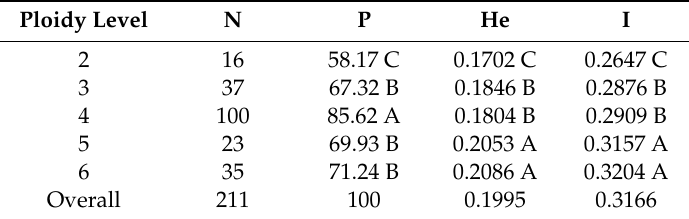
Table 4. Genetic diversity of bermudagrass of di ff erent ploidy levels.